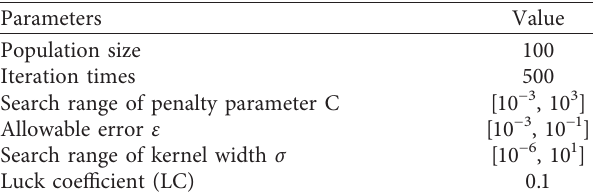
Table 4: List of preset parameters in DA-VNS.